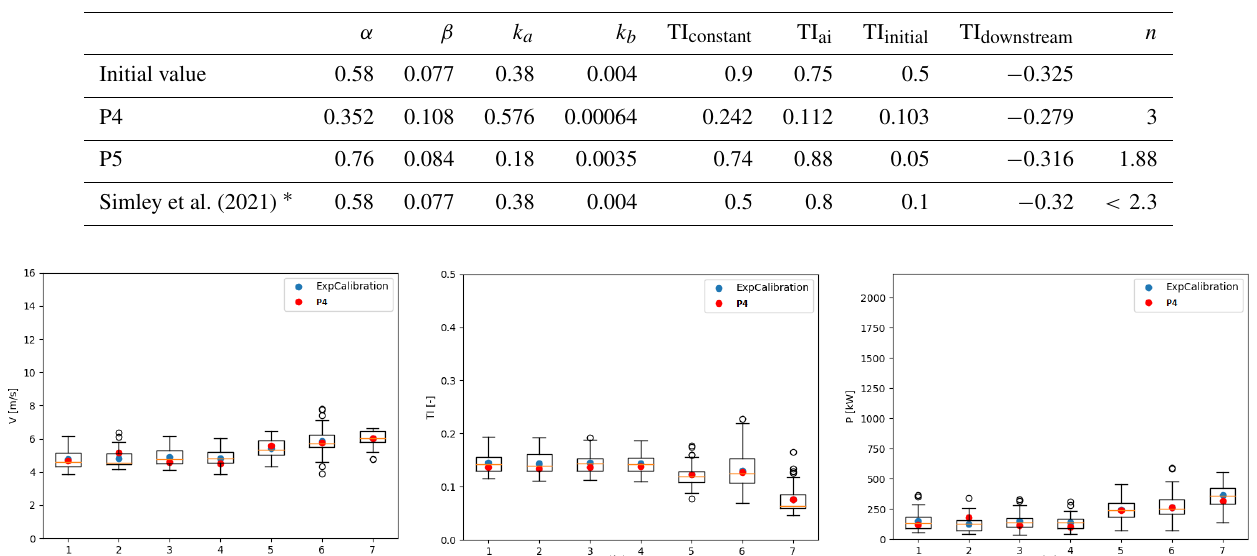
Table 6. Calibrated parameters of the used velocity and turbulence sub-models of the relevant models used by participants P4 and P5, where α and β ; k a and k b ; and TI constant , TI ai , TI initial , and TI downstream are model parameters in FLORIS (NREL, 2021), and n is the yaw loss exponent in Eq. (1). ∗ In Simley et al. (2021), the wake model fitting was realized by tuning the ambient turbulence intensity value rather than updating the model parameters. Within FLORIS (NREL, 2021), the Gauss velocity model (Bastankhah and Porté-Agel, 2014, 2016; Blondel and Cathelain, 2020; King et al., 2021) was used rather than the Gauss legacy model (Bastankhah and Porté-Agel, 2014, 2016) as for P4 and P5.